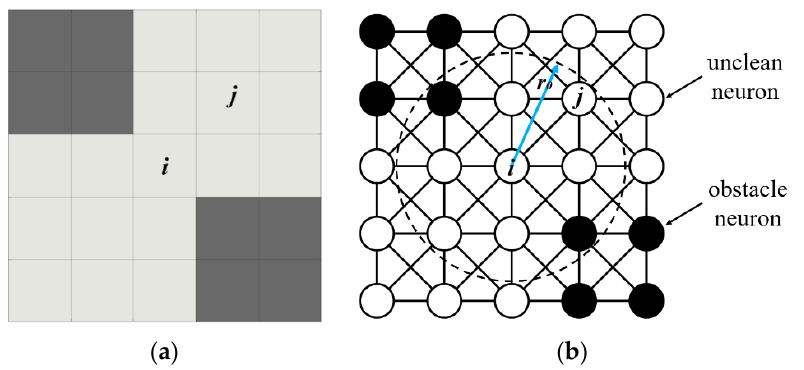
Figure 2. A neural network based on a grid map in the BINN algorithm: ( a ) Grid Map. ( b ) Corre- sponding neural network.